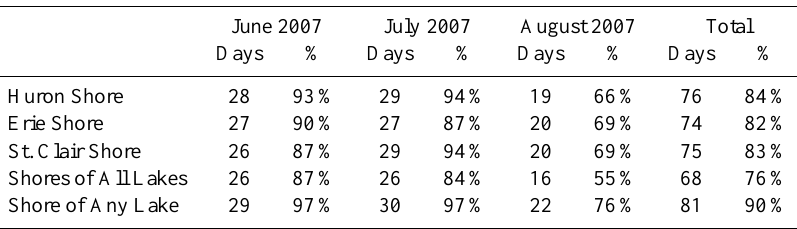
Table 2. The number and percentage of days per month with observed lake breezes, plus the total number and percentage for all study days. Values are grouped by shore